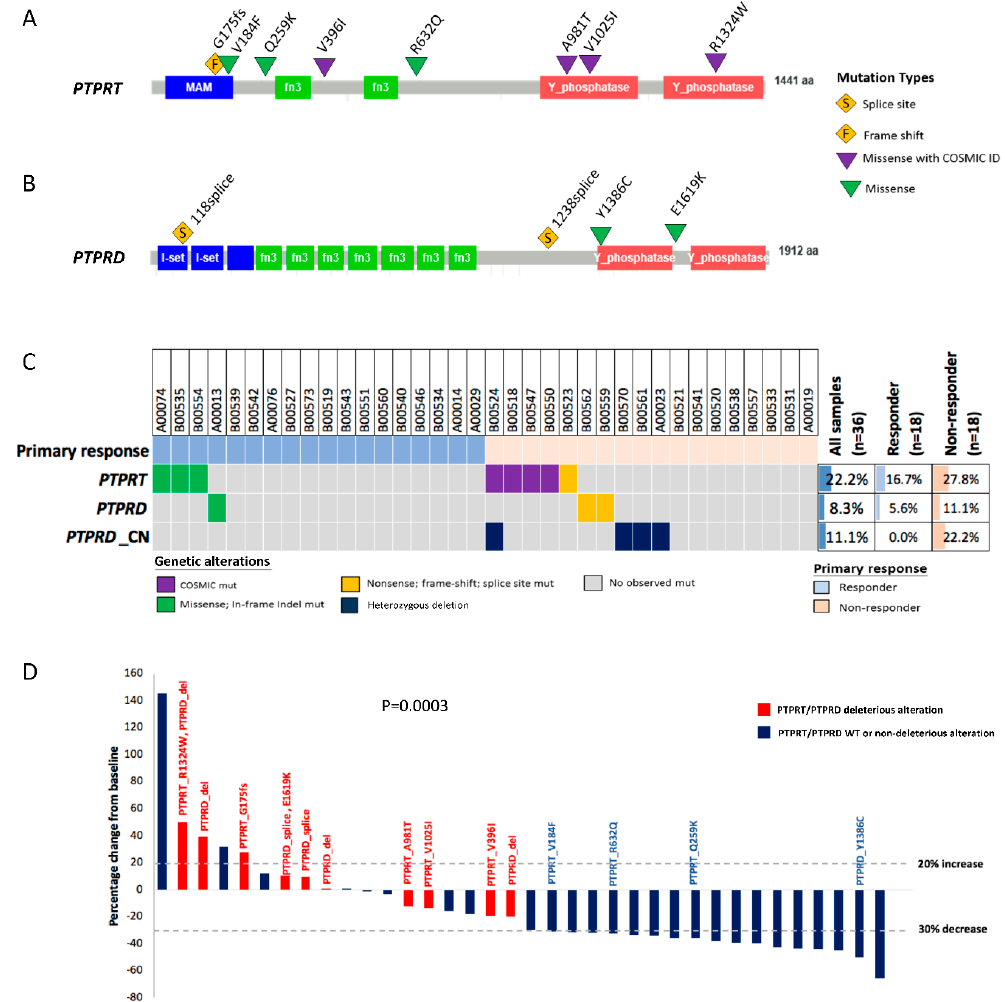
Figure 3. Observed PTPRT/PTPRD genetic alterations and bevacizumab response. Detected